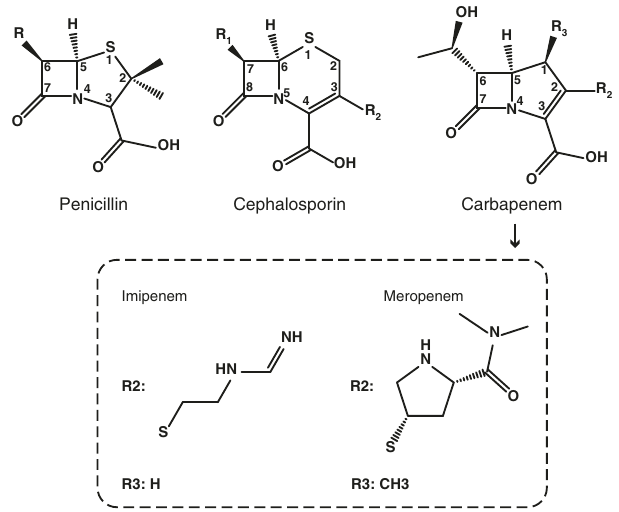
Fig. 1 Chemical structures of penicillin, cephalosporin, and carbapenem. The chirality of C6 is S in carbapenems, contrary to R at the same position in penicillins and cephalosporins. The R2 and R3 side chains of imipenem and meropenem are shown in the dashed